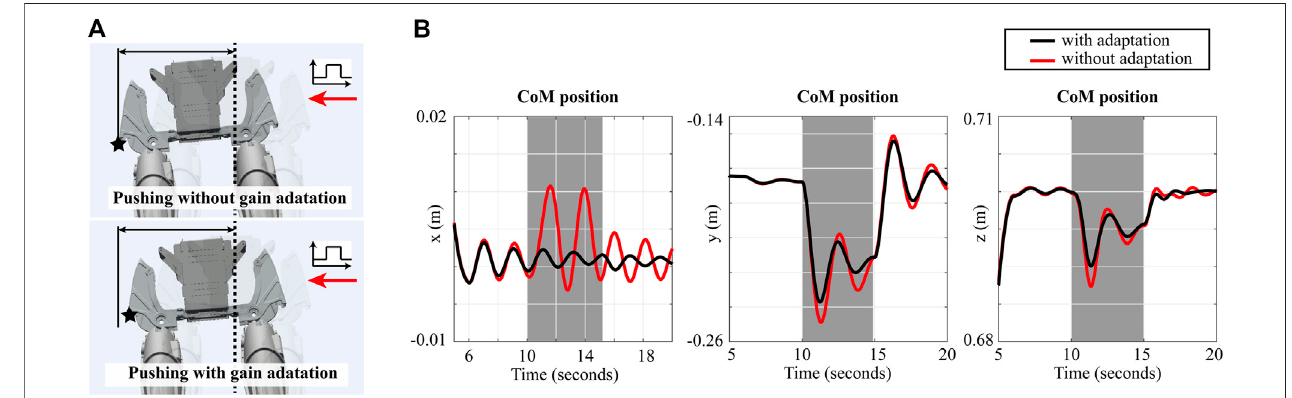
FIGURE3|(A) Snapshotsofcontrolsimulations:theupperandlower fi guresshowbalancingbehaviorswithandwithoutgainadaptation,respectively.Ablackstar marks the edge point on the hip shell as a measurement reference. (B) Comparison between the positions of the robot ’ s CoM using standard WBLC versus adaptive WBLC, where the desired x and y positions of the CoM is the center position between two feet [3.80, × , 10 – 5 , − 0.167] m, and the desired height of the CoM is 0.7